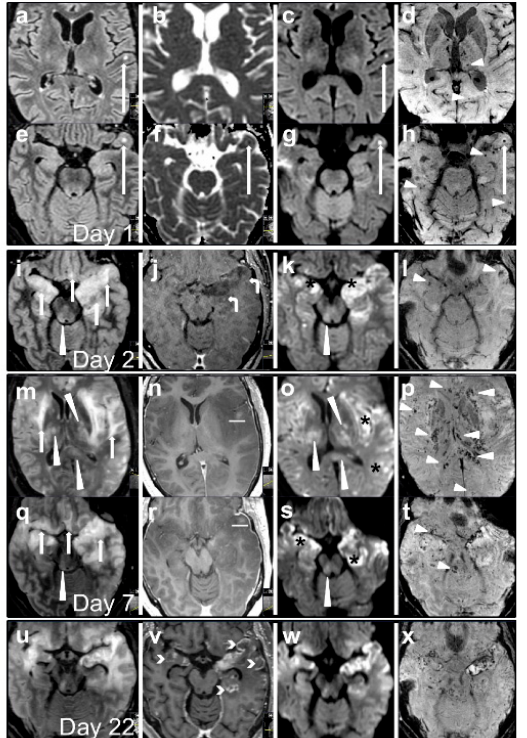
Figure 2. Axial MRI illustrating the evolution of brain lesions from day 1 ( a – h ), 2 ( i – l ), and 7 ( m – t ) to 22 ( u – x) at the level of temporal lobes ( e – l , q – x ) and the level of the insula and basal ganglia ( a – d , m – p ) on fluid ‐ attenuated inversion recovery (FLAIR) ( a , e , i , m , q , u ), apparent diffusion coefficient (ADC) ( b , f ), diffusion ‐ weighted (DWI) ( c , g , k , o , s , w ), susceptibility ‐ weighted (SWI) and T1 ‐ weighted contrast ‐ enhanced images ( j , n , r , v ). Focal lesions on the first day (long arrow heads in a – h ). Progression of extensive confluent areas of striking FLAIR hyperintensity (short arrow heads in i , m , q ) in temporal, frontobasal, and insular regions as well as moderate FLAIR hyperintensity (long arrow heads in i , k , m , o , q , s ) in basal ganglia, brainstem and corpus callosum, with the marked progression of petechial hemorrhages on SWI (small arrowheads, d , h , l , p , t ), restricted diffusion on DWI (asterisk in k , o , s ), leptomeningeal contrast ‐ enhancement (curved arrow heads in j ) and hemorrhagic transformation (horizontal white line in n , r ). On day 22 contrast enhancement with cortical laminar necrosis appeared (brackets in v ) and swelling started to reduce (widening of sulci and temporal horns of the lateral ventricles in u , v , w compared to q , r , s ).